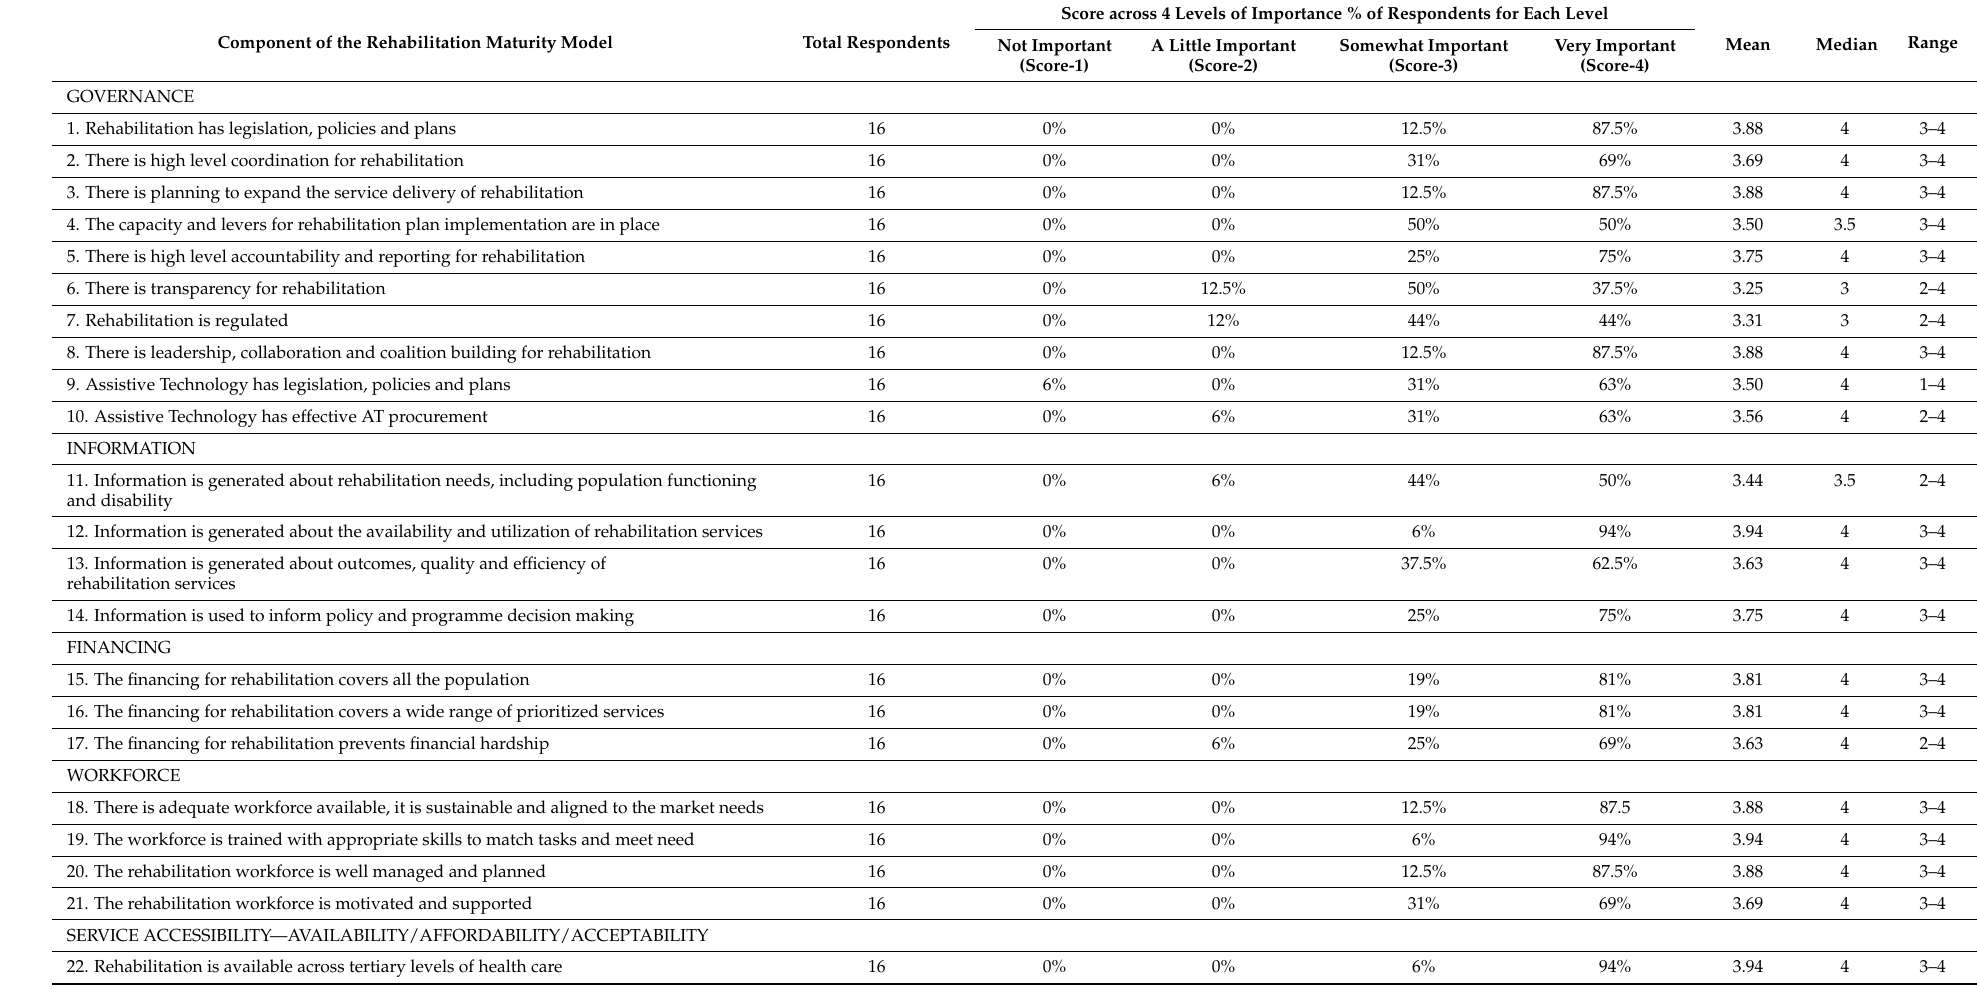
Table 4. Rehabilitation Maturity Model Components—Results of Rating